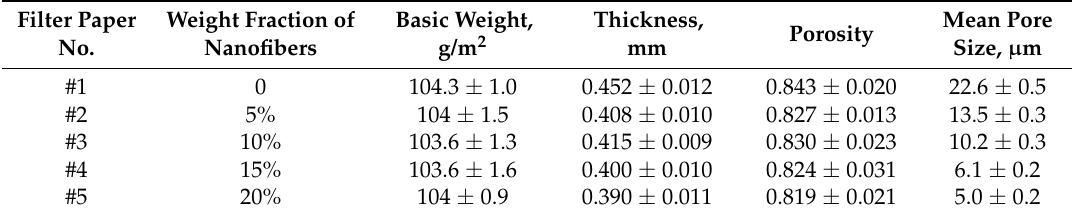
Table 3. Physical properties of filter paper containing nanofiber.